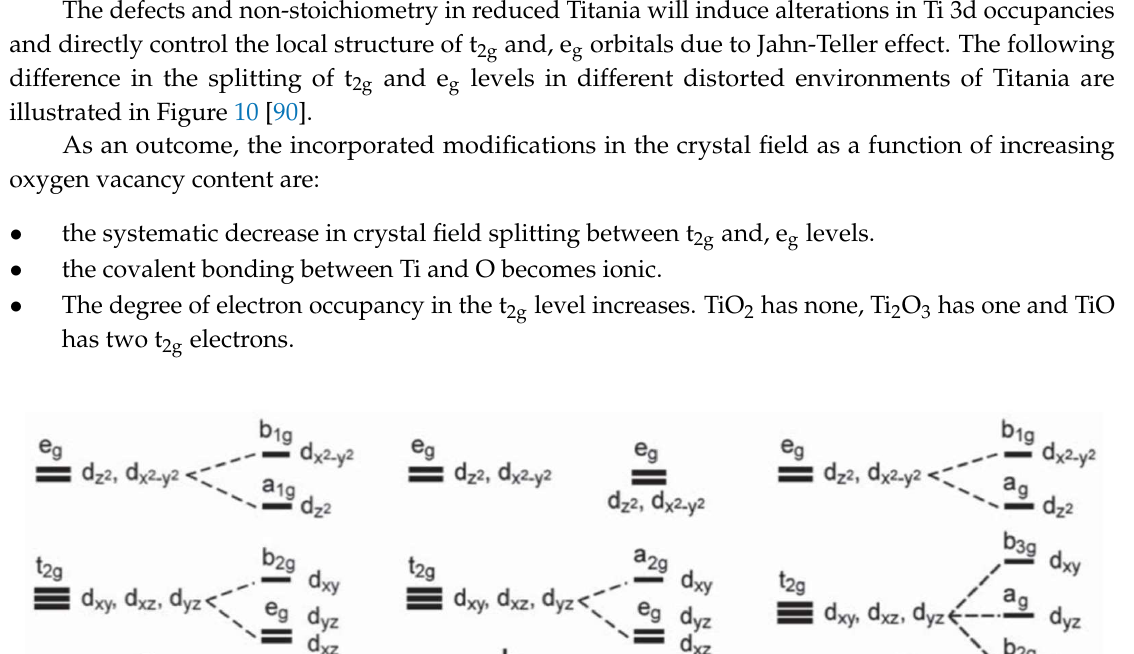
Figure 10. Splitting of t 2g and, e g levels in tetragonal ( a ), trigonal ( b ), and orthorhombic ( c ) distorted environments. Reproduced from [90], Copyright 2007, American Mineralogist. Besides the above-described changes in crystal symmetry and coordination number, the extent of mixing of Ti 3d and O 2p orbitals is also affected, and, hence, their electronic band structure and band gap vary on titanium oxide polymorphs. It is also known that the oxygen vacancy and titanium interstitial behave as donor states since their energy level is closer to the conduction band; while titanium vacancy forces the Fermi level towards the valence band, to accept electrons from their surrounding O atoms and act as an acceptor state [49,120–125]. The distinct energy levels of various defect states in titanium oxide are shown in Figure 11 [86].